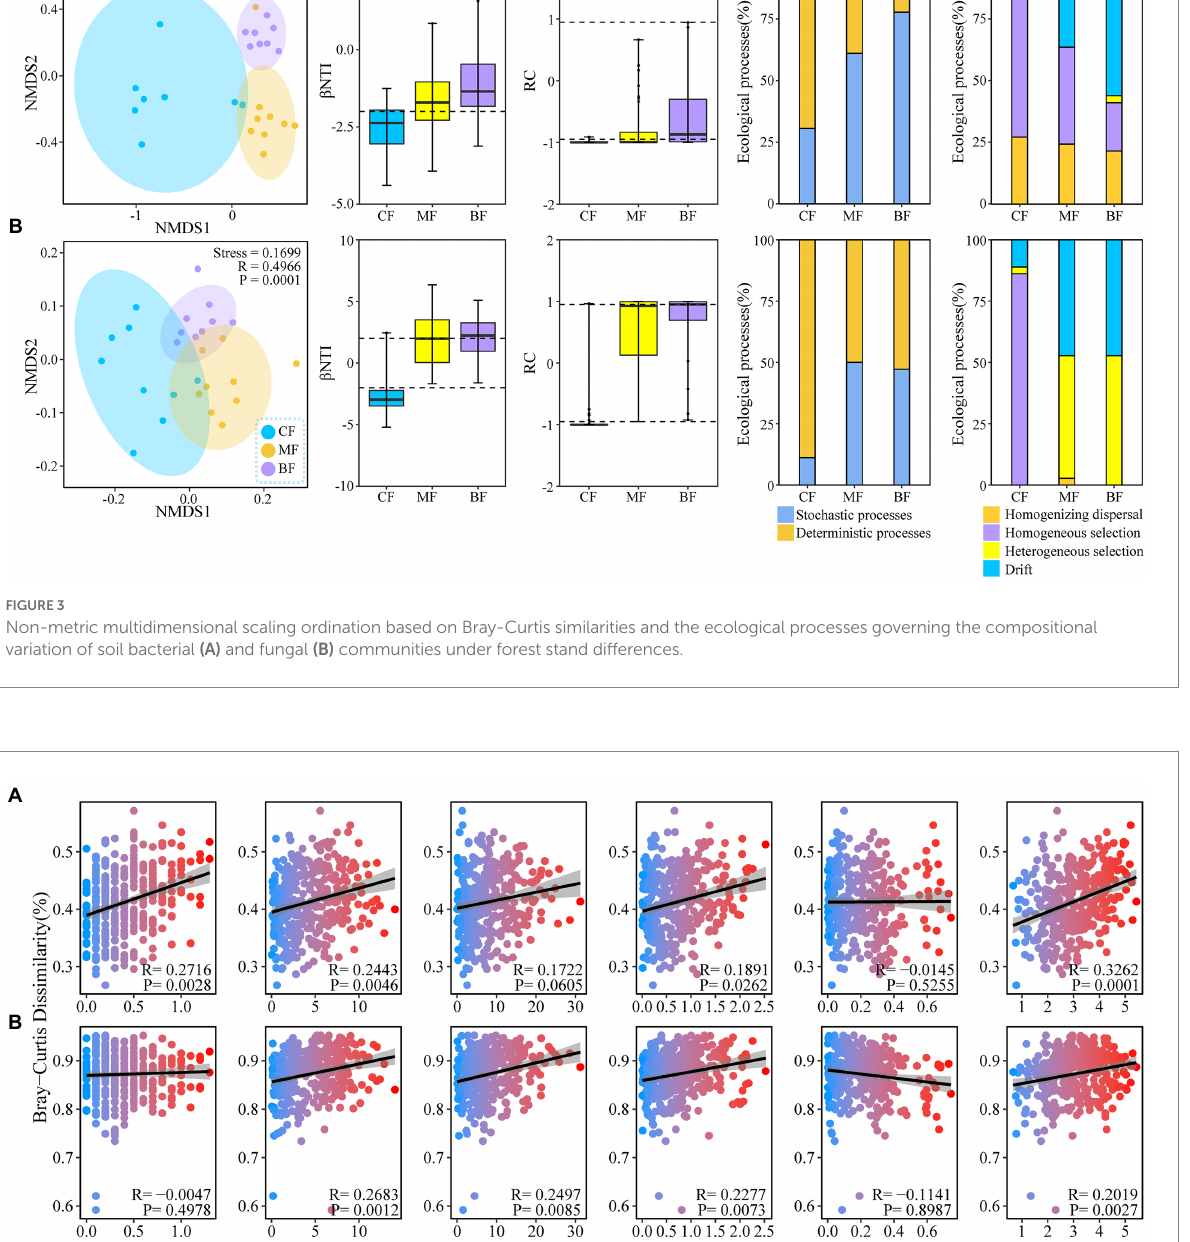
Rozellomycota (3.6–1.1%) and Chytridiomycota (1.3–1.1%)